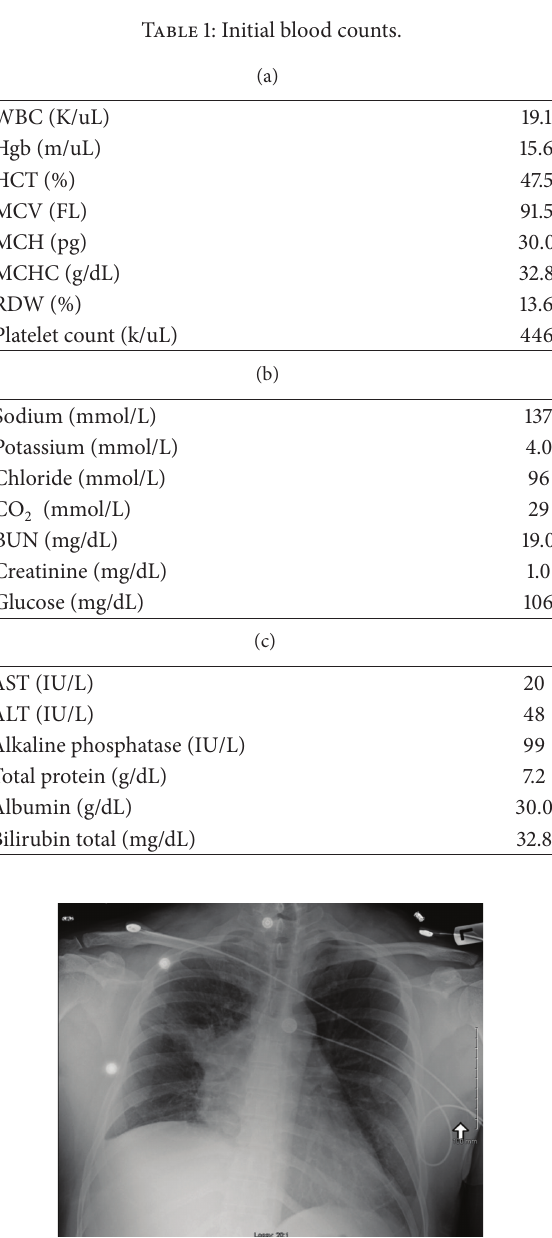
Figure 1: Chest X-ray showing a large right hilar mass extending to the right upper lobe with associated fine loss in the right lung. There is a right pleural effusion seen as